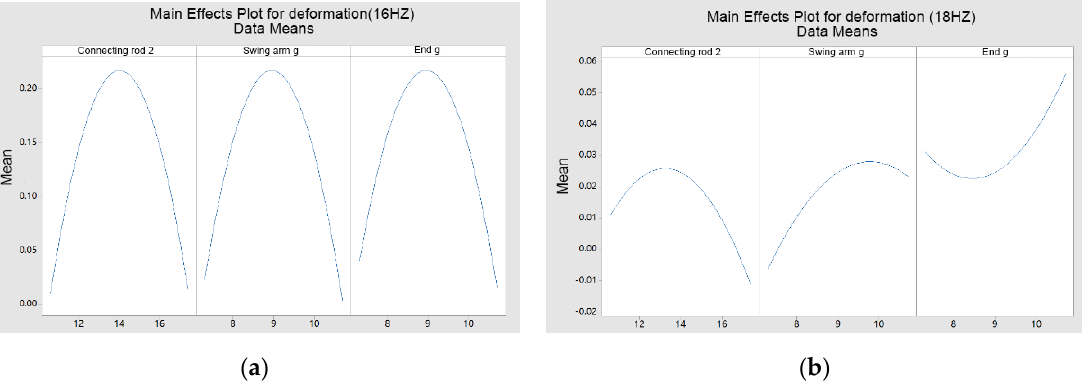
Figure 19. The main effect diagrams of the maximum displacement at the end: ( a ) 16 Hz;( b ) 18 Hz.